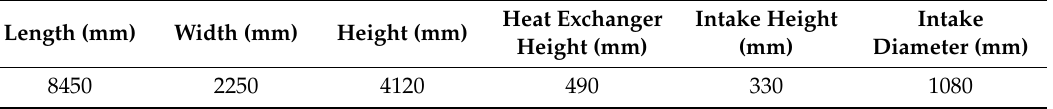
Table 1. Dimensions of the AlphaLaval Lu-Ve BD-1000 evaporator.